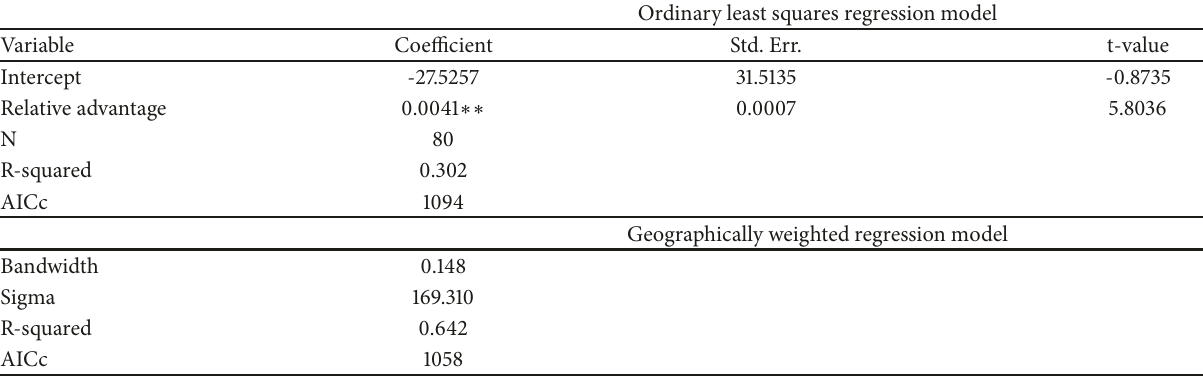
Table 5: Estimation results of the ordinary least squares regression and geographically weighted regression models. Ordinary least squares regression